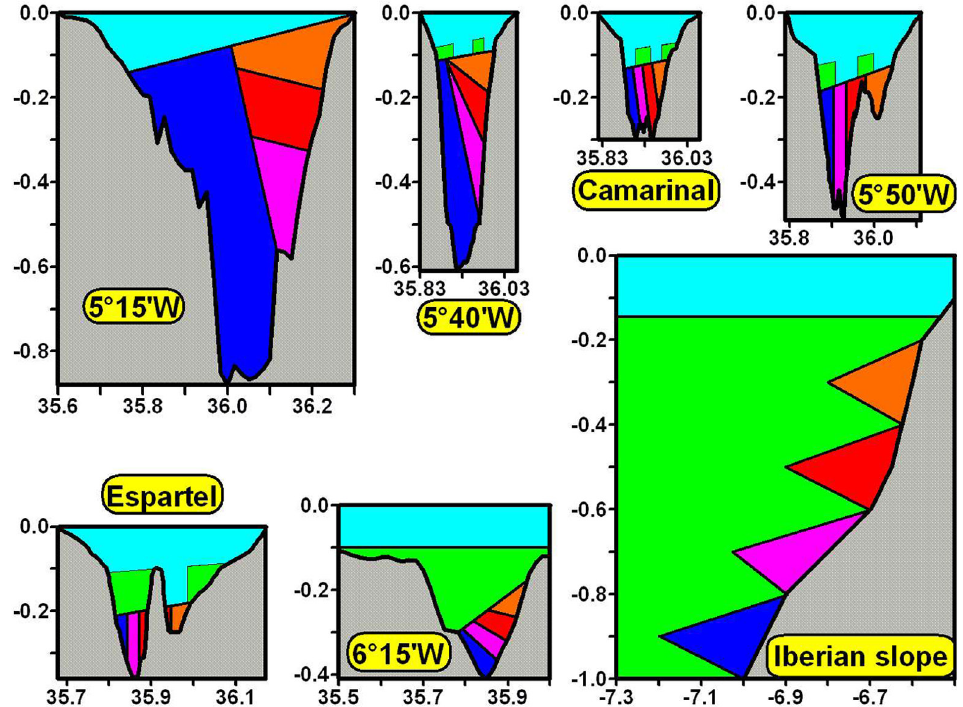
Fig. 6. – This is Figure 31 of Millot (2013b) schematizing, in the area around the Strait of Gibraltar, the distribution of SAW (Surface Atlantic Water, cyan), NACW (North Atlantic Central Water, green), WIW (Western Intermediate Water, orange), LIW (Levantine Intermediate Water, which we propose to name EIW, for Eastern Intermediate Water, red), TDW (Tyrrhenian Dense Water, pink) and WMDW (Western Mediterranean Deep Water, blue). If the hypothesis put forward in Millot (2013a) and herein were validated, apart from the blue colour that should still be associated with WMDW, the other colours should be associated more with mixtures of each of the IWs than with the IWs